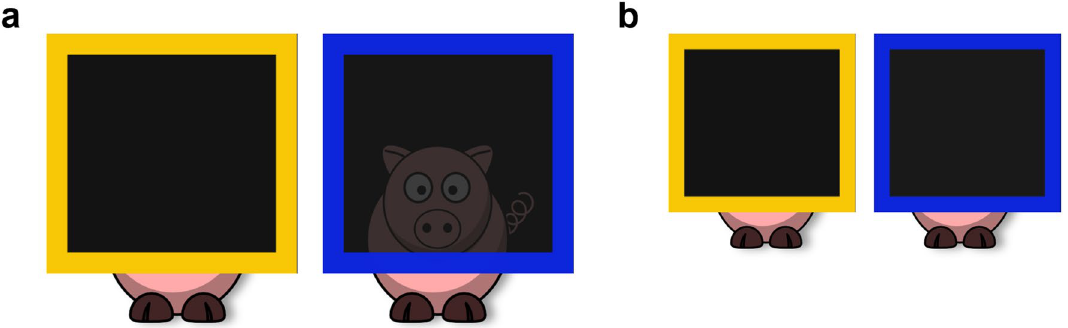
Figure 1. Illustration of the perceptual access afforded by the opaque (yellow) and semi-opaque (blue) screens when interrupting the view of another object. ( a ) when viewed close up, illustrative of child’s view during the experience phase; ( b ) when viewed at a distance, illustrative of child’s view during pre-switch and switch